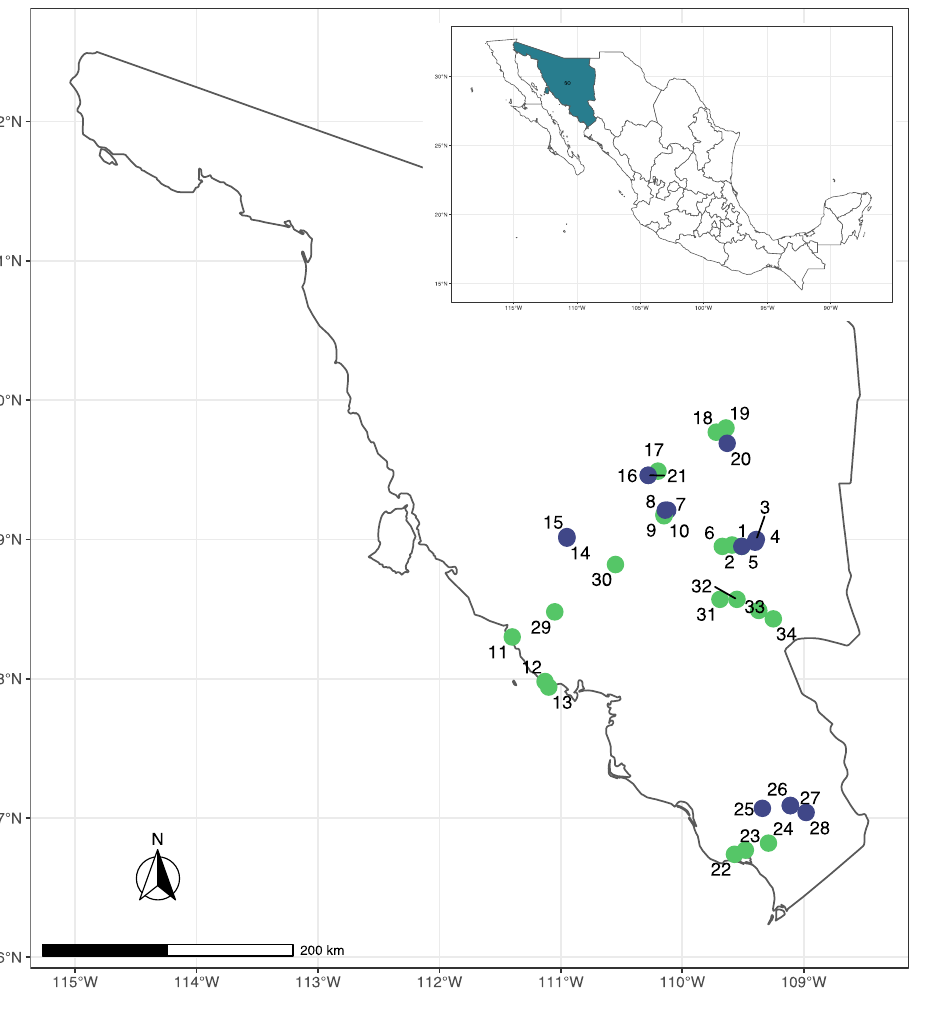
Figure 5. Map showing sampling sites of wild (green) and cultivated (blue) Agave angustifolia var. pacifica from the state of Sonora, Mexico. The full names of each site and sample sizes are given in Table S1.